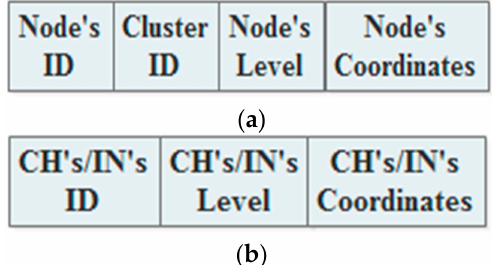
Figure 3. The announcement messages in the static approach: ( a ) the Normal member node (N)’s message; ( b ) the Cluster Head (CH)’s/ Independent Node (IN)’S